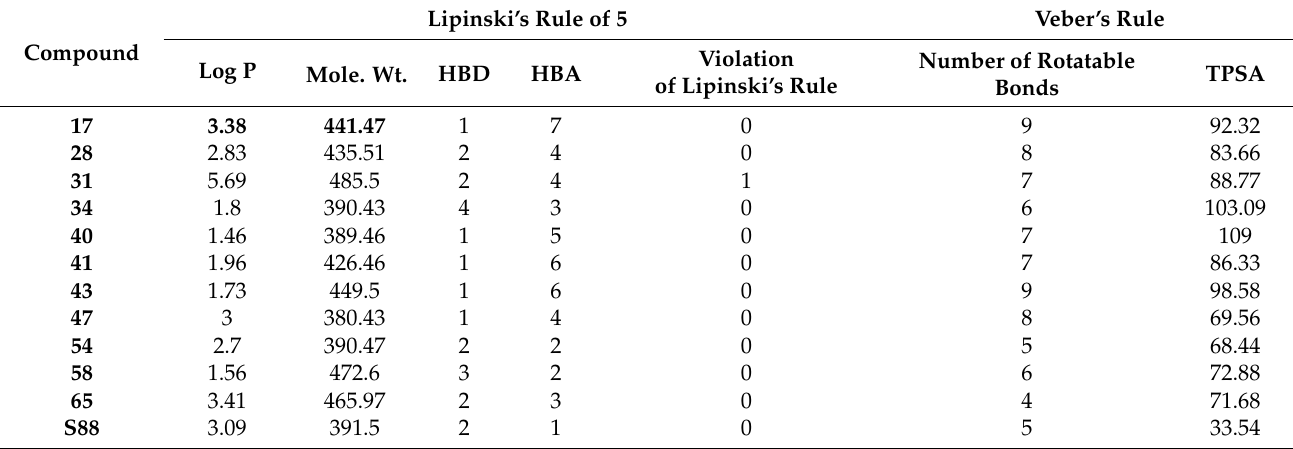
Table 2. Physicochemical properties of the semi-synthesized molecules under study.